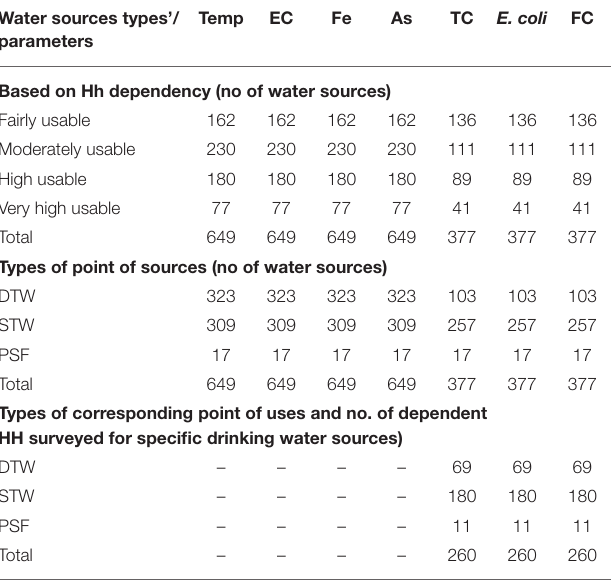
TABLE 1 | Distribution of tested drinking water sources, water quality parameters and no. of surveyed dependent HH. Water sources types’/